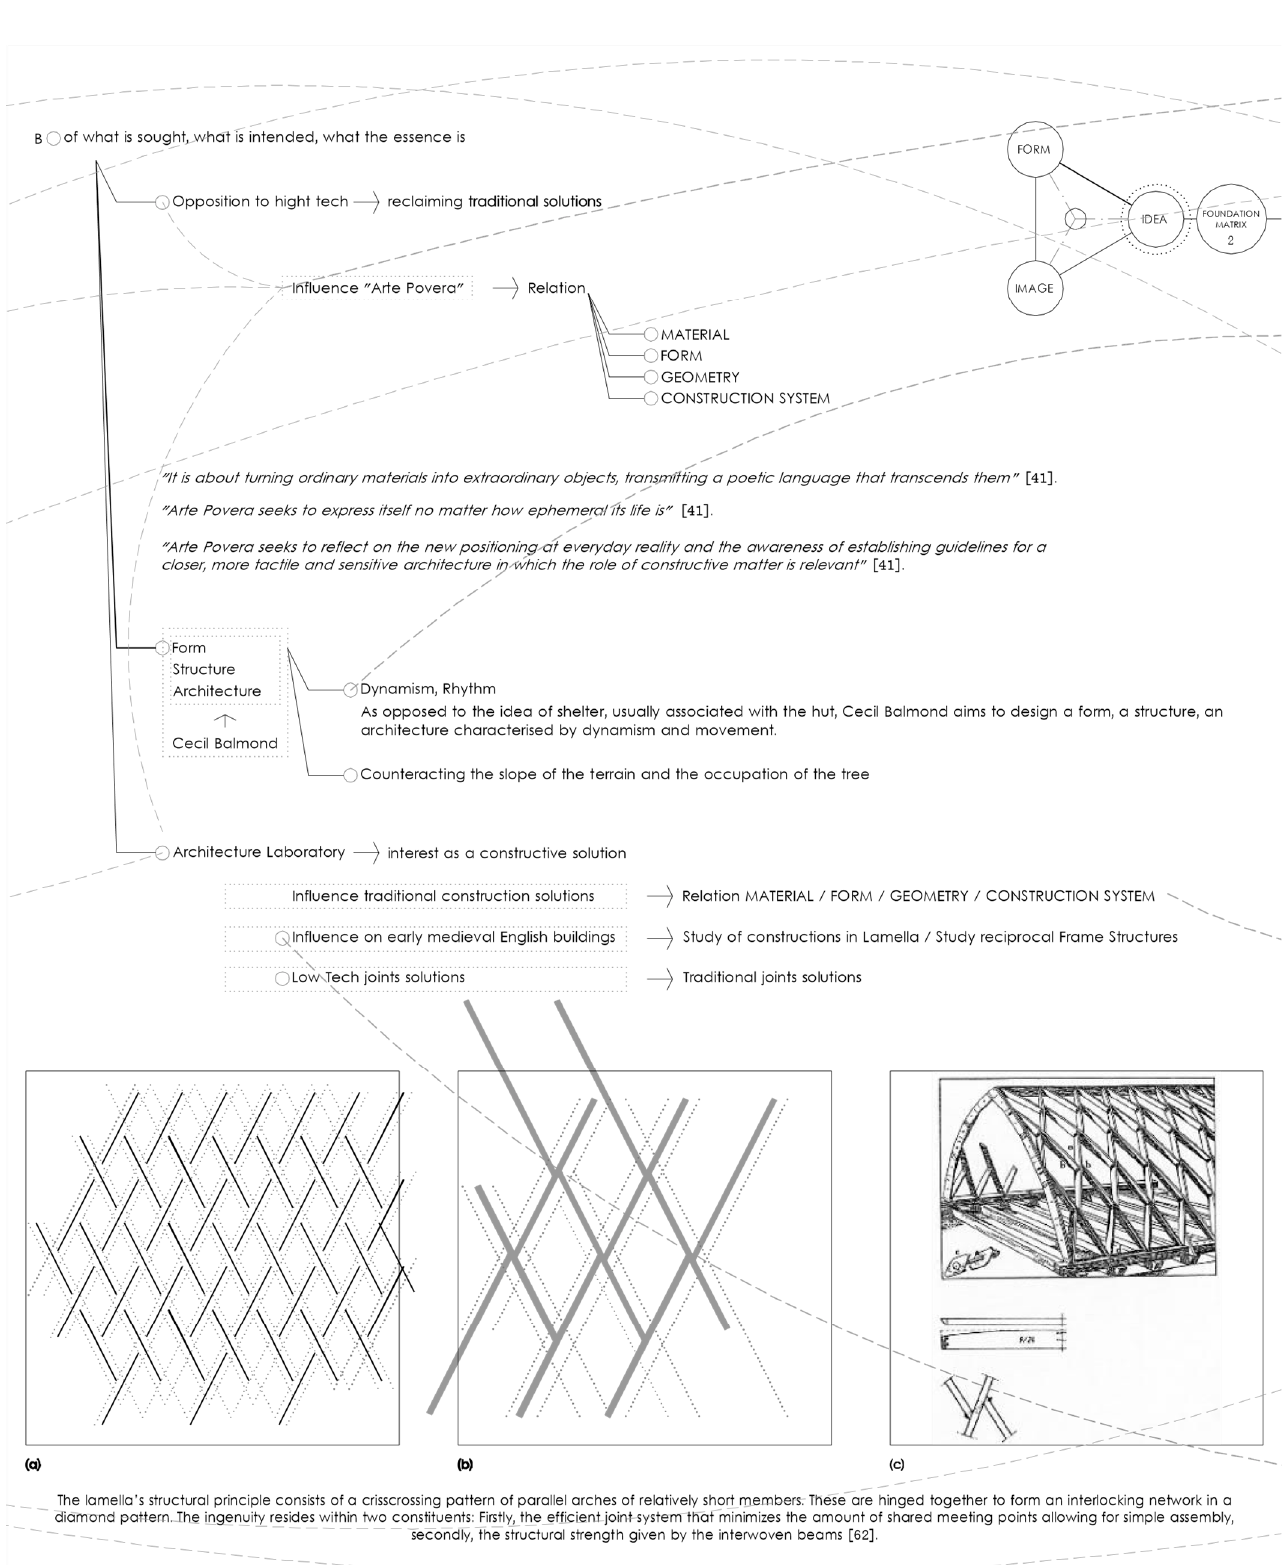
Figure 7. Foundation matrix 2. ( c ) Zollinger lamella roof drawing [71].